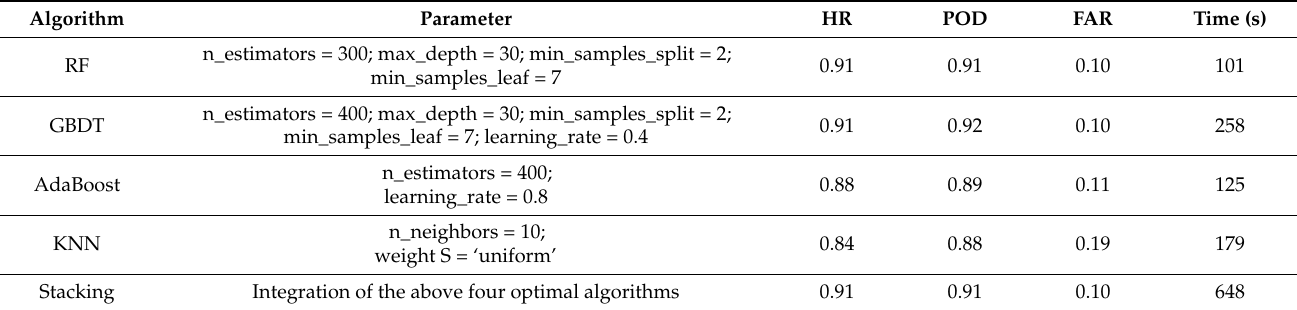
Table 2. Performance of CP classification based on five ML algorithms with optimized parameters.